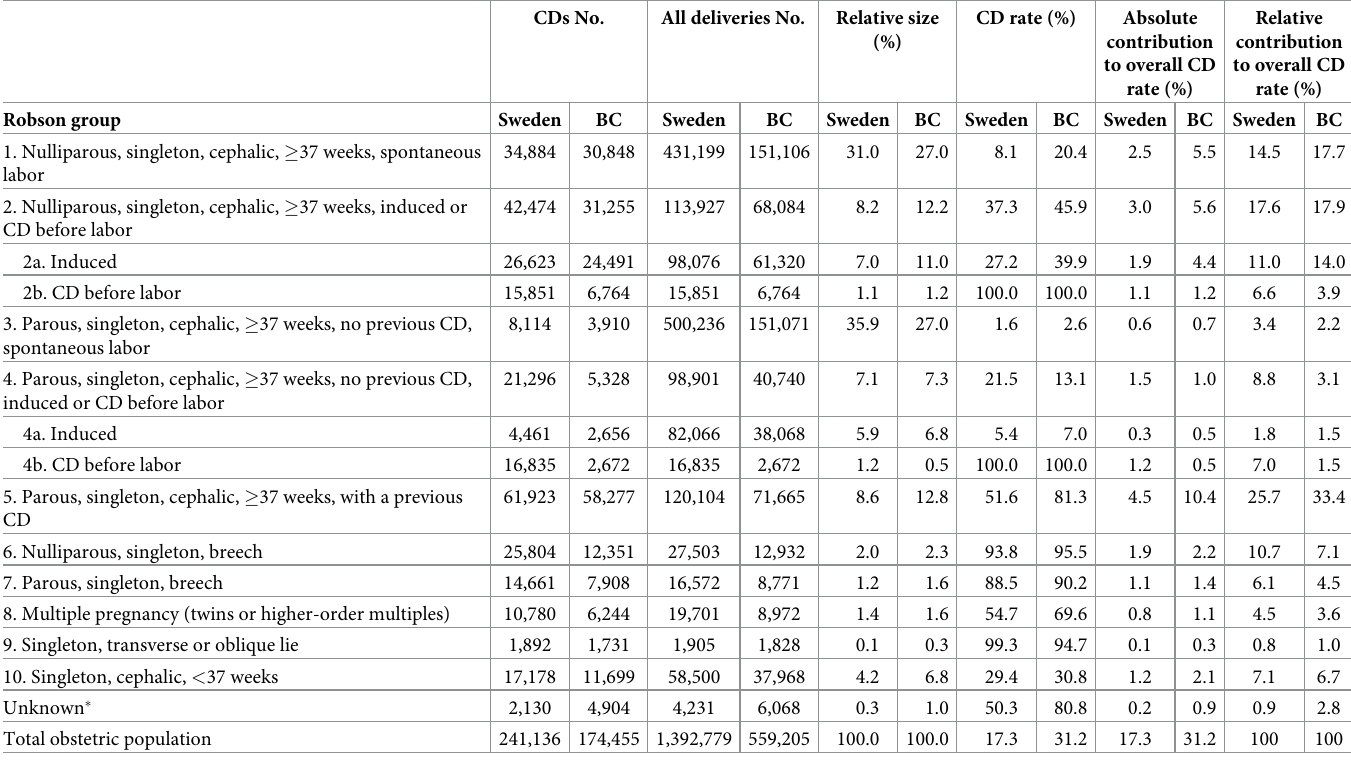
Table 2. The Robson Classification Report Table [9], Sweden and BC, Canada, 2004–2016.